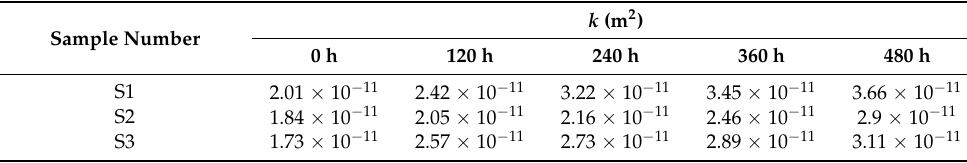
Table 5. Calculated permeability at different leaching times.